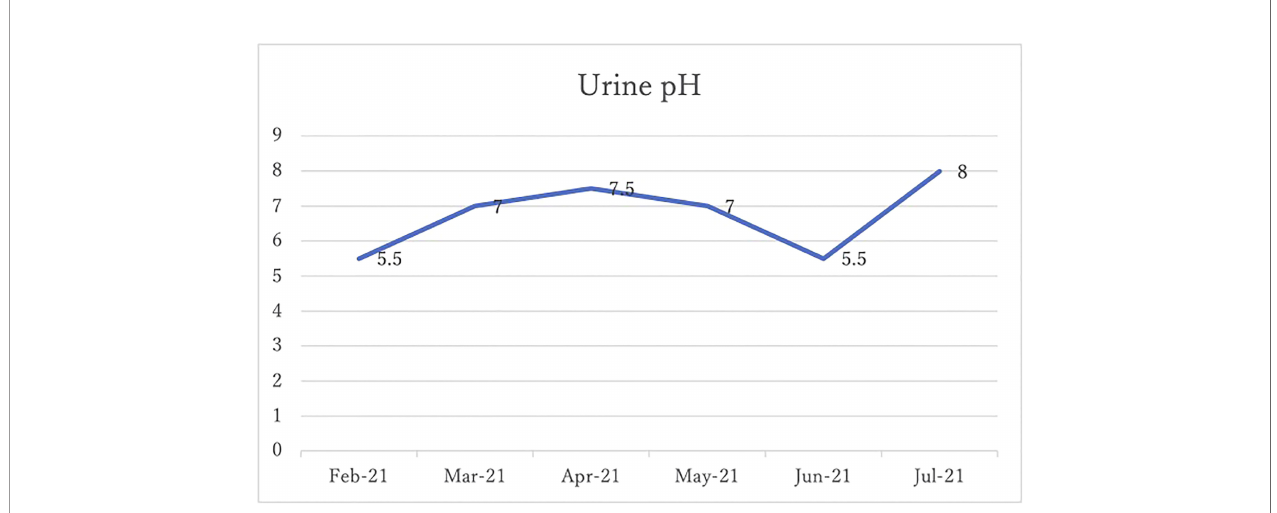
FIGURE 3 | His urine pH levels are